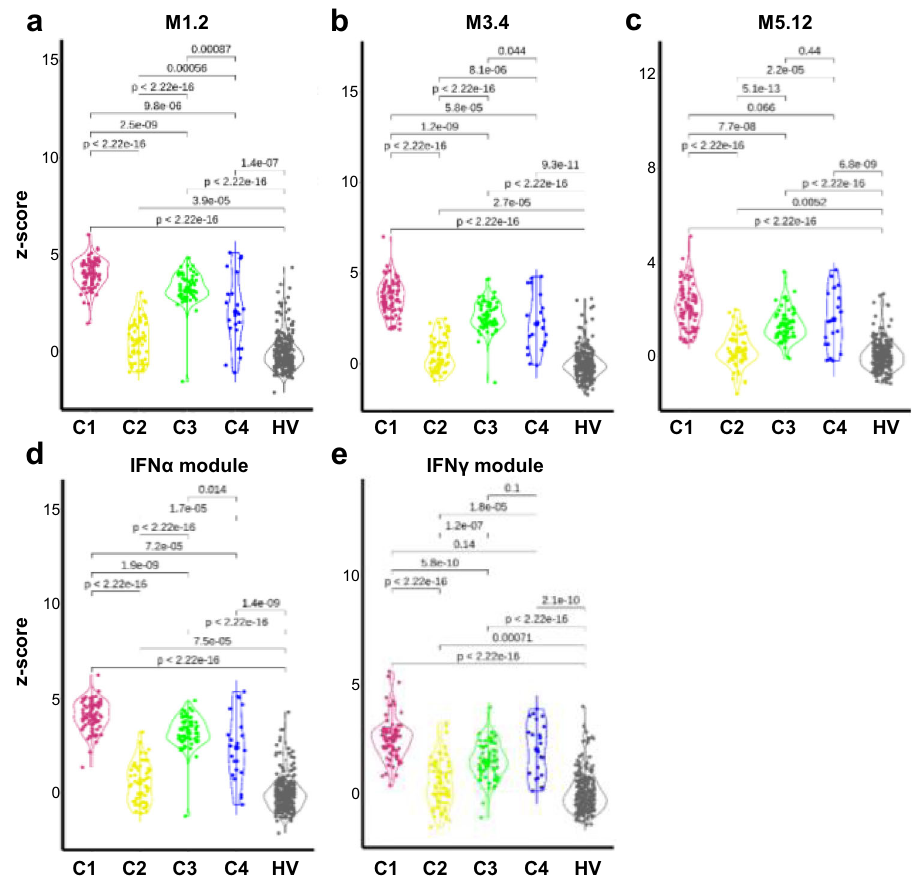
Fig. 3 The 4 pSS clusters show typical IFN signature according to modular IFN z-scores. IFN score analyses were performed for 304 pSS patients and 330 healthy volunteers (HV). Repartition of samples from the 4 pSS clusters are shown according to the most characterized IFN module z-scores. The genes ( IFI44 , IFI44L , IFIT1 and MX1 ) of the M1.2 module ( a ) are induced by IFN α , while genes from both M1.2 and M3.4 ( b ) ( ZBP1 , IFIH1 , EIF2AK2 , PARP9 and GBP4 ) are up-regulated by IFN β . c The genes ( PSMB9 , NCOA7 , TAP1 , ISG20 and SP140 ) from the M5.12 module are poorly induced by IFN α and IFN β alone while they are up-regulated by IFN γ . Moreover, transcripts belonging to M3.4 and M5.12 were only fully induced by a combination of Type I and Type II IFNs 10 . Other modules identi fi ed genes preferentially induced by IFN α ( IFIT1 , IFI44 and EIF2AK2 ) ( d ) or IFN γ ( IRF1 , GBP1 and SERPING1 ) ( e ) 12 . Two-tailed pairwise Wilcoxon-rank sum test results are shown. Plots show median with error bars indicating ± interquartile range.